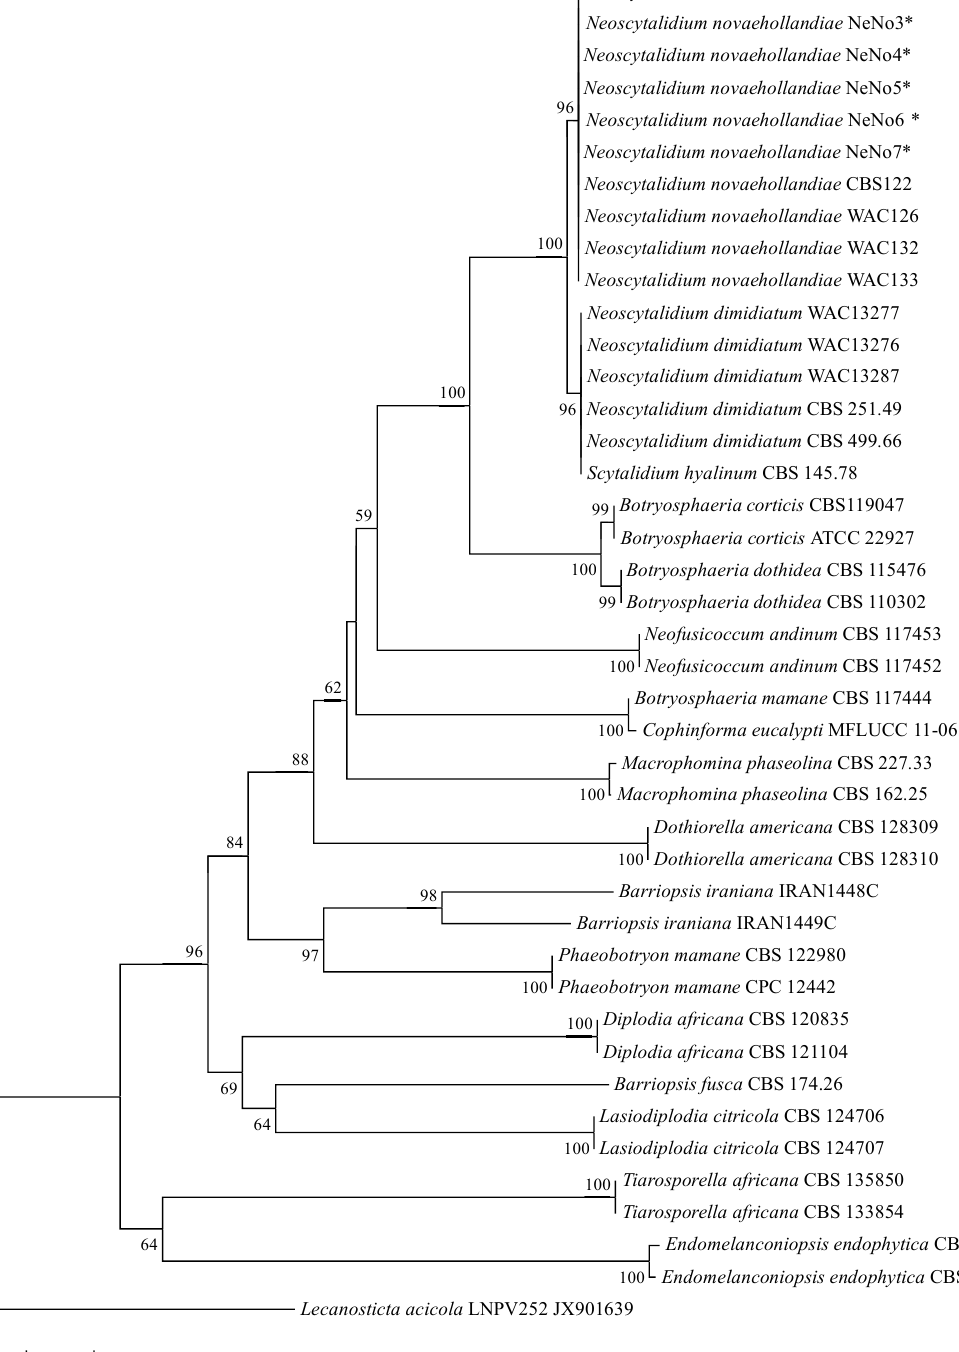
Figure 3. Maximum likelihood phylogram generated in Mega 5 from the alignment of 42 combined internal transcribed spacer (ITS) and translation elongation factor 1-alpha (EF1) gene portion datasets, using the Tamura 3-parameter model with complete deletion gap han- dling and 1,000-replication bootstrapping. The values associated with each horizontal the line denote bootstrap support for the node. Iso- lates of Neoscytalidium novaehollandiae cluster to a highly supported terminal clade separate from isolates of N. dimidiatum. The isolates from Iran are each marked with a